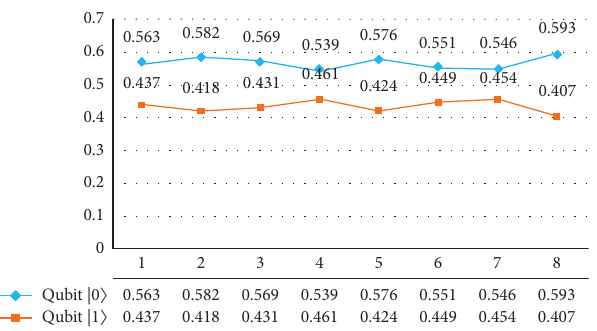
Figure 10: The measurement result of |0 〉 and |1 〉 after running Algorithm 3 8 times on Rigetti.